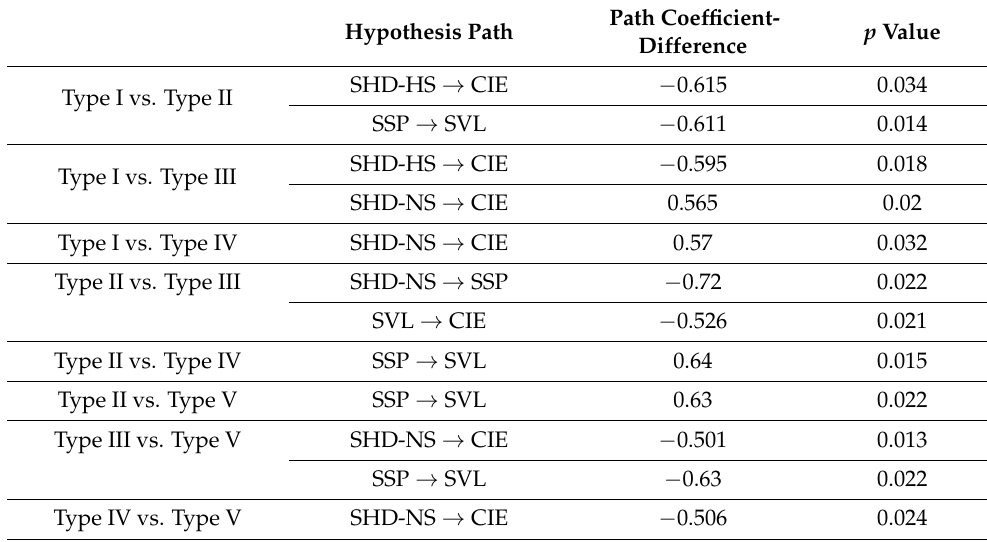
Table 9. The coefficient difference between the same path in different functional